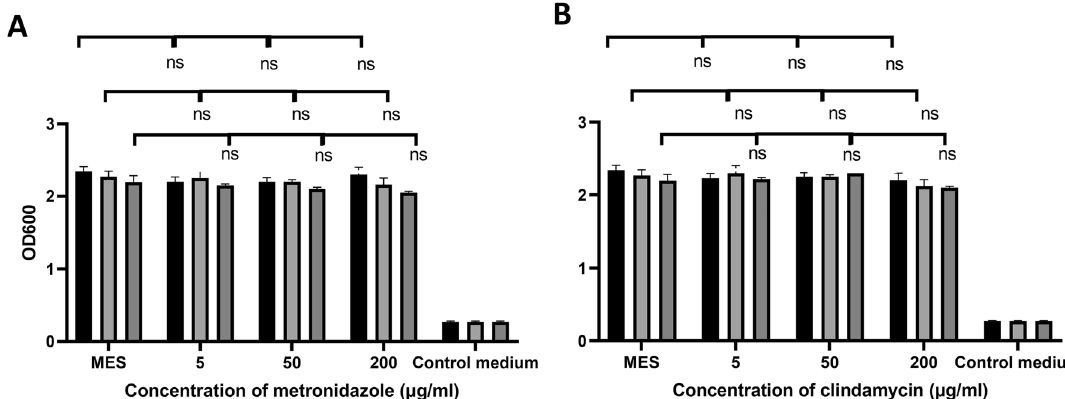
Fig. 5 Antibiotic bio fi lm disruption activity : Pre- formed bio fi lm disruption assays using G. vaginalis ATCC14018, G. vaginalis UG860107 and G. vaginalis BUL001 bio fi lms. Final concentrations of A metronidazole or B clindamycin from 5 to 200 μ g/ml, were used to disrupt bio fi lms. OD 600 readings are the average of biological triplicates plus/minus their standard deviation. No statistical differences are represented by ns. Controls: MES corresponds to bacteria with MES buffer and control medium is the no bacterial control. p -values for ANOVA and Tukey